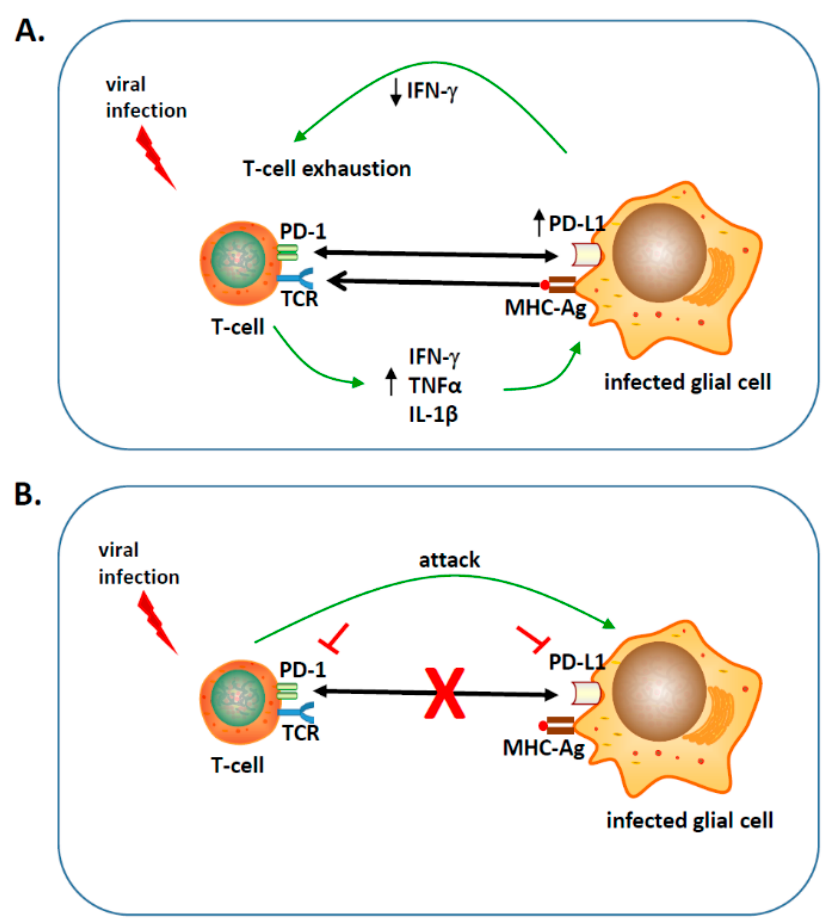
Figure 1. Glial cell modulation of T lymphocytes via the programmed death (PD)-1: PD-L1 pathway. ( A ) Engagement of the PD-1 receptor by its ligand PD-L1 results in functional suppression of brain-infiltrating T-cells. This results in controlled neuroinflammation, suppression of disease severity, and limited bystander tissue damage, but may also support persistent viral infection. ( B ) Blocking the PD-1: PD-L1 negative checkpoint results in the attack of infected glia by effector T-cells resulting in rapid viral clearance, but it may also promote reactive gliosis, exacerbated neuroinflammation, and disease severity. represents blocking either PD-1 or PD-L1 using inhibitors; indicates blocking the PD-1: PD-L1 pathway; engagement of PD-1 to PD-L1; binding of major histocompatibility complex-antigen (MHC- Ag) to T-cell receptor (TCR)